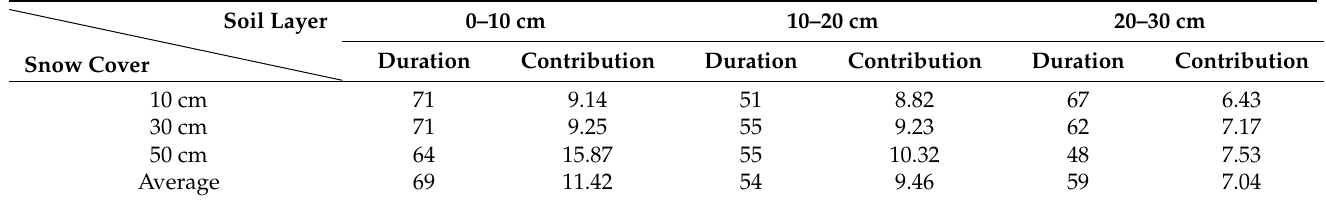
Table 6. Contributions (%) and their retention times(d) of the different snow depths to the soil